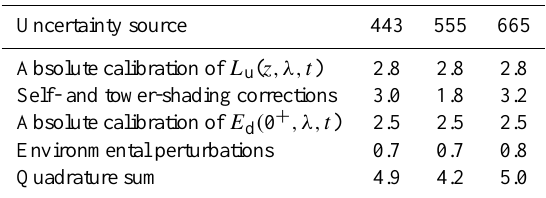
Table 3. Uncertainty budget (in percent) for R rs determined from WiSPER